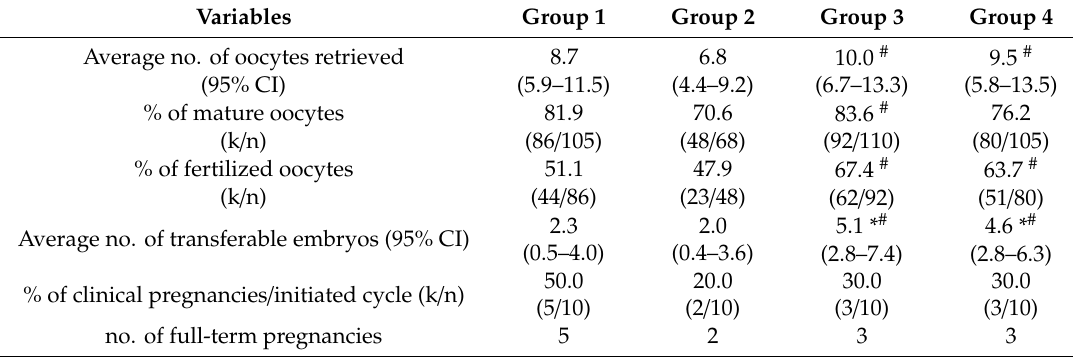
Table 2. Clinical outcomes of in vitro fertilization (IVF)-embryo transfer in fertile women and patients with unexplained infertility treated with di ff erent dosages of